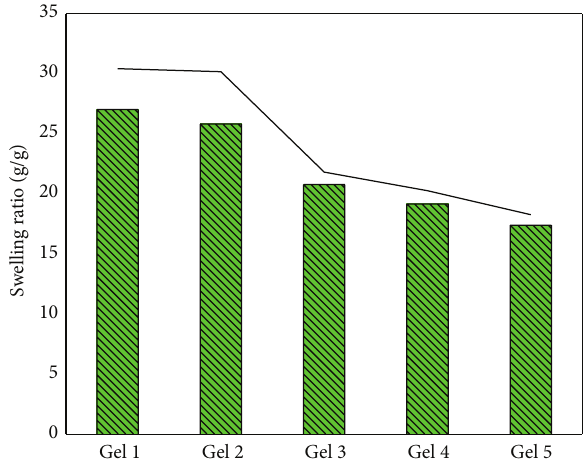
Figure 5: Equilibrium swelling ratio of the prepared cellu- lose/MWCNTs hydrogels after immersing in distilled water for a week, as the function of the composition of MWCNTs and cellulose at 25 ∘